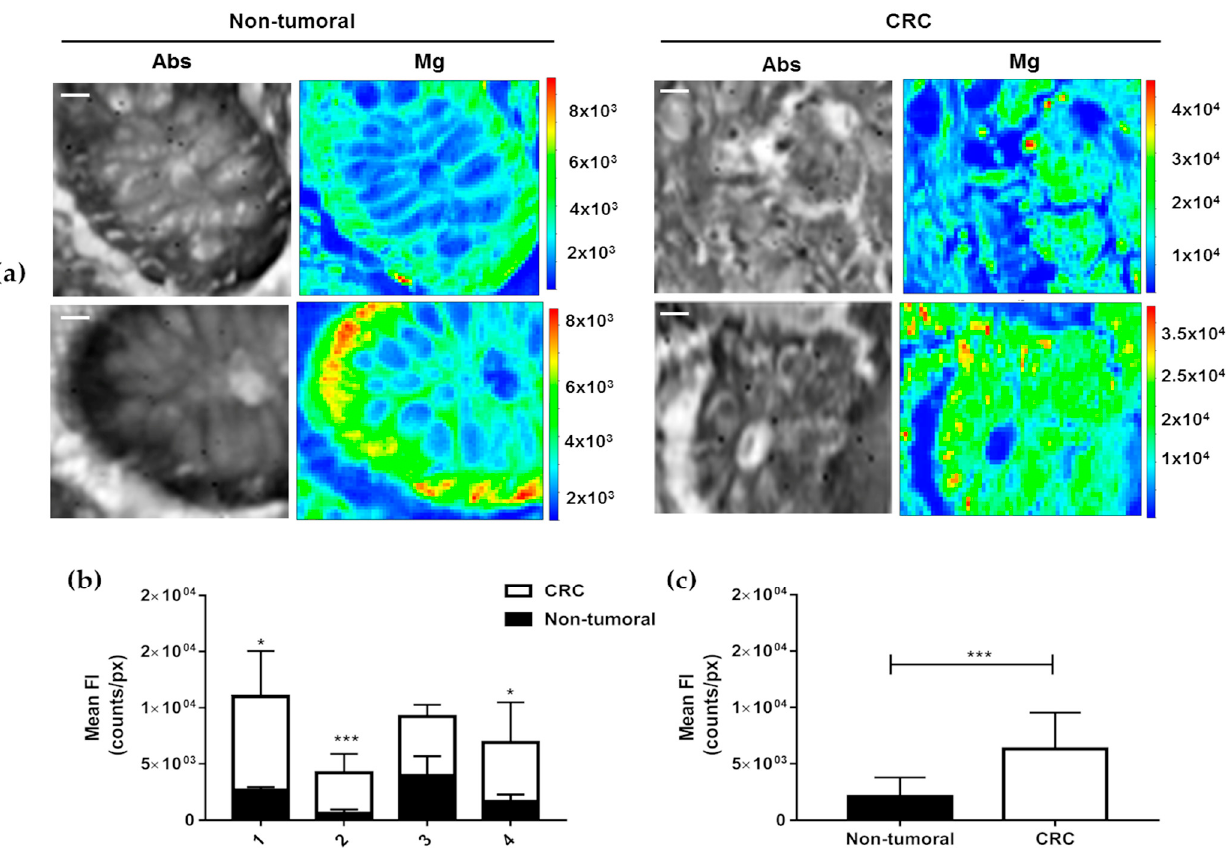
Figure 2. XRFM analysis. ( a ) Tissue morphology (Abs) and Mg content and distribution of non-tumoural colon epithelium (left panel) and CRC (right panel) tissues. The images shown are representative of the four patients under study; XRFM acquisition time= 6 s/pixel, Incident Energy= 1470 eV. Scale bars are 10 µ m. Analysed areas: 78 × 78 µ m 2 and 78 × 60 µ m 2 . ( b ) Mean fluorescence intensities of total Mg counts for each patient under study and ( c ) overall total Mg counts obtained considering all the Mg counts from each patient under study in non-tumoural adjacent and CRC tissues. Total counts were estimated by selecting the overall XRFM analysed areas and normalising the total counts by the size of area itself (pixels). Data are presented as mean ± SD. Non-tumoural (n = 21) and CRC (n = 15). The statistical significance was determined by Students’ t -test. * p -value < 0.05. *** p < 0.001.